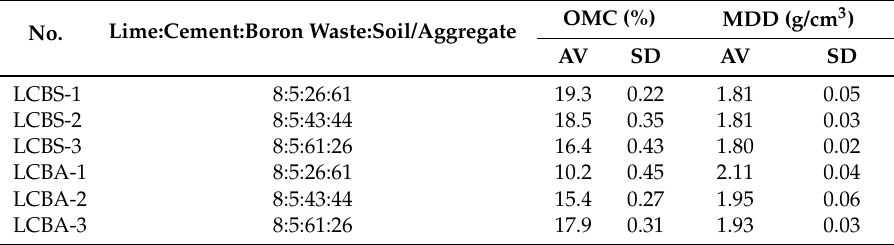
Table 6. Results of the compaction test.